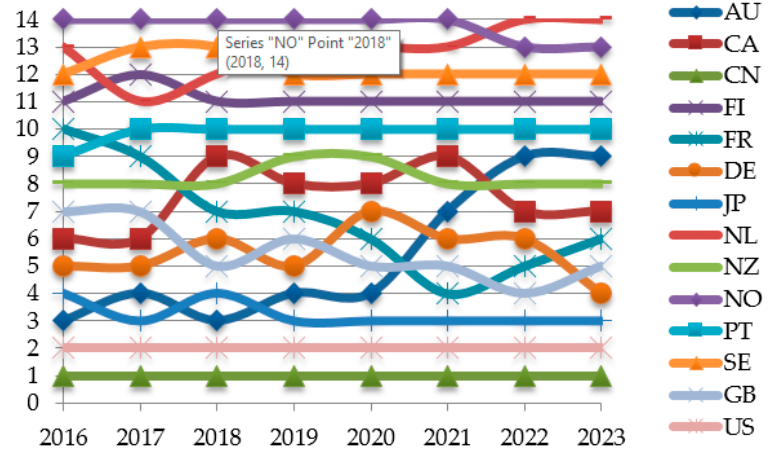
Figure 2. Position of countries from past to future.